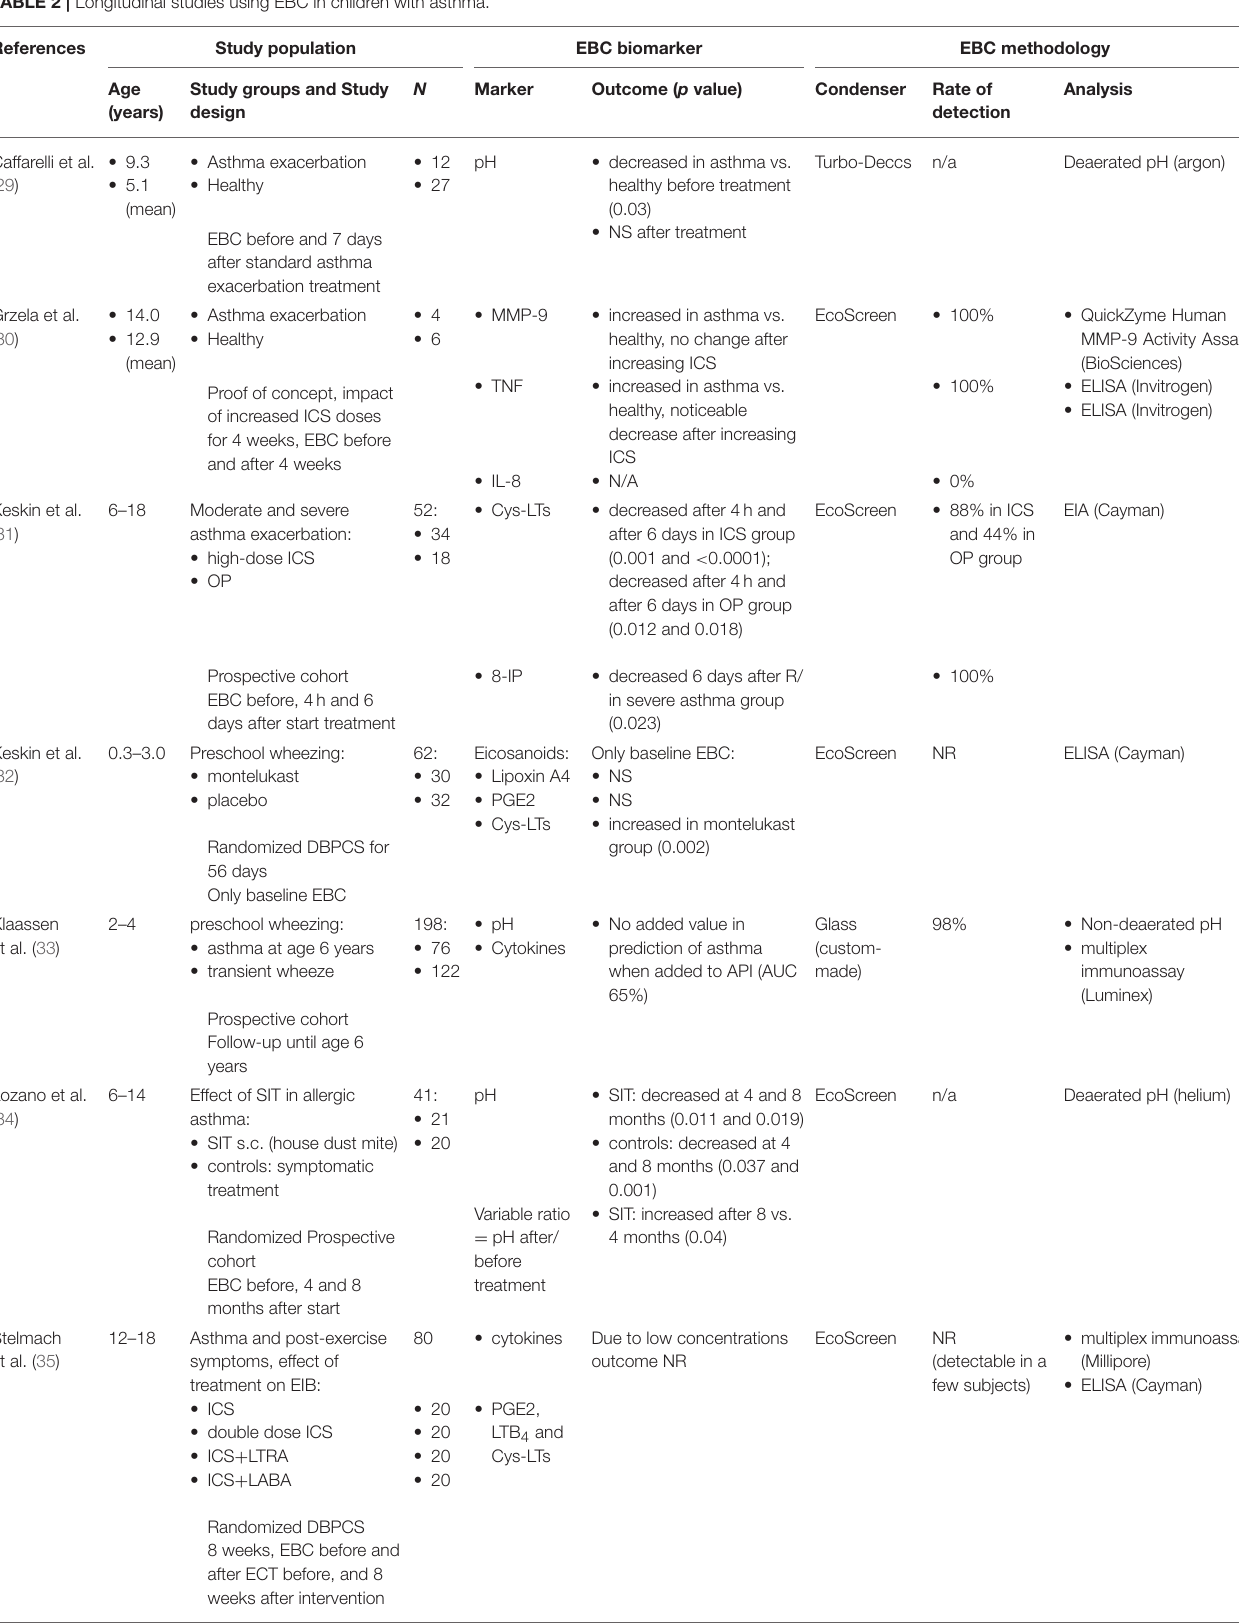
TABLE 2 | Longitudinal studies using EBC in children with